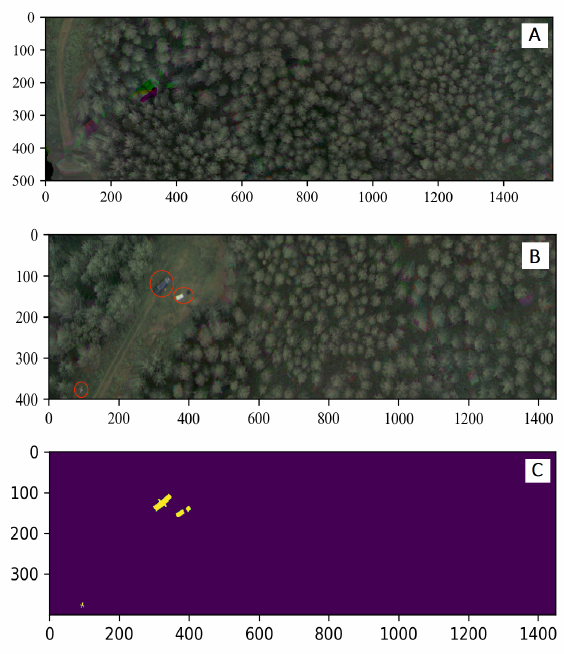
Figure 4: Image A: The training data for the anomaly detection from the forest. Image B: The forest dataset’s test data for the anomaly detection. Inside the red circulated areas are the anoma- lous objects (three reflectance panels and one black panel, one blue van, and a cross-shaped georeferencing signal). The third image is the hand-drawn ground truth image, for the test data. Images A and B are originally from (P¨ol¨onen et al., 2020).